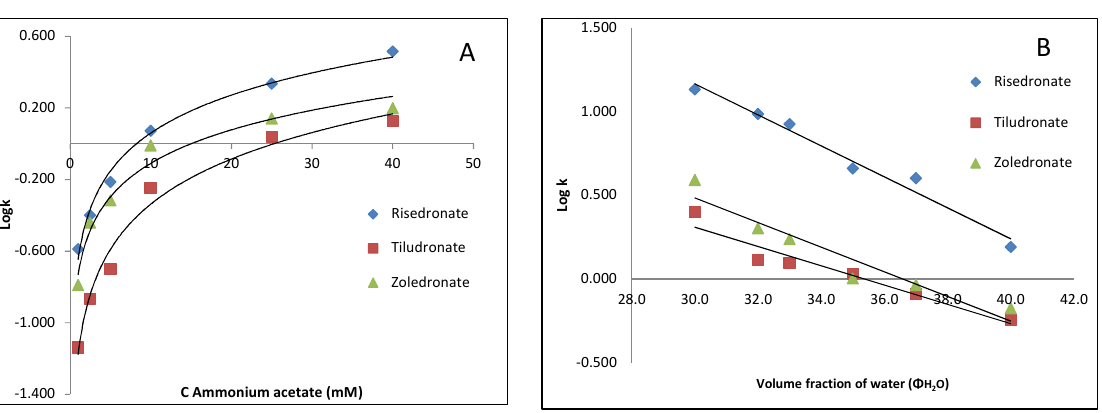
Figure 2. Α) Impact of the concentration of ammonium acetate (mM) on the log k. ZIC®-pHILIC column; mobile phase: acetonitrile/ammonium acetate aqueous solution pH 6.6 (65:35, v / v ), Β) Impact of the percentage of water, Φ water , on the log k. ZIC®-pHILIC column; mobile phase: acetonitrile/ammonium acetate aqueous solution pH 6.8 containing 3.5 mΜ ammonium acetate in